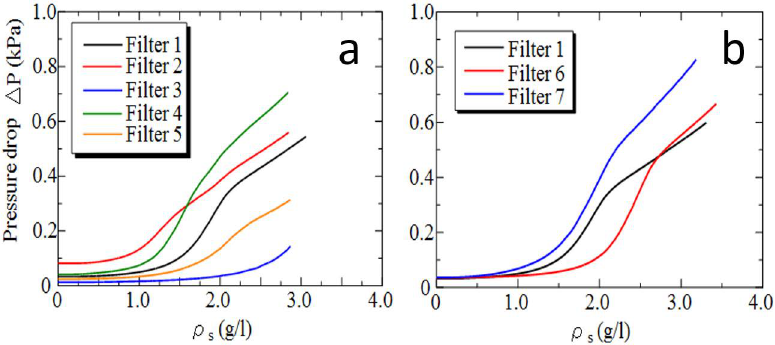
Figure 11. Relationship between deposited soot mass and pressure drop in Filters 1 to 7. ( a ) Filters 1–5; ( b ) Filters 1, 6, 7.